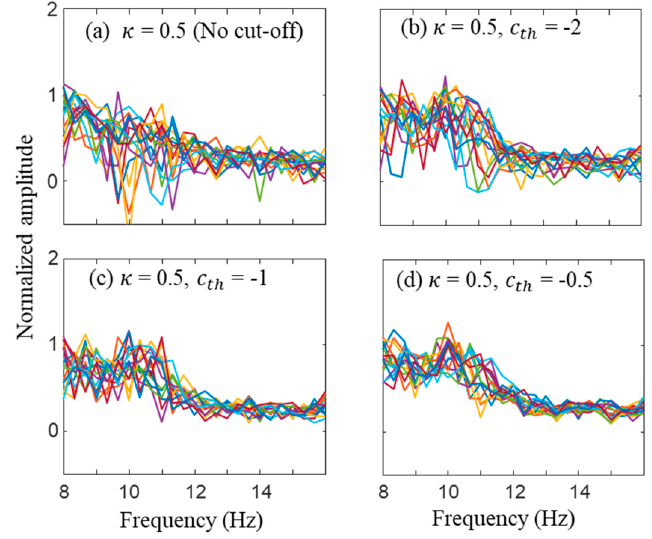
Figure 8. Augmented data of Class 1 with GNDv2: ( a ) κ = 0.5 and no cut-off; ( b ) κ = 0.5 and e t h = − 2; ( c ) κ = 0.5 and c t h = − 1; ( d ) κ = 0.5 and e t h = − 0.5. Table 1. Effects of data cut-off on classification accuracy. The GNDv2 with κ = 0.5 was used. The numbers in parentheses represent the standard errors.